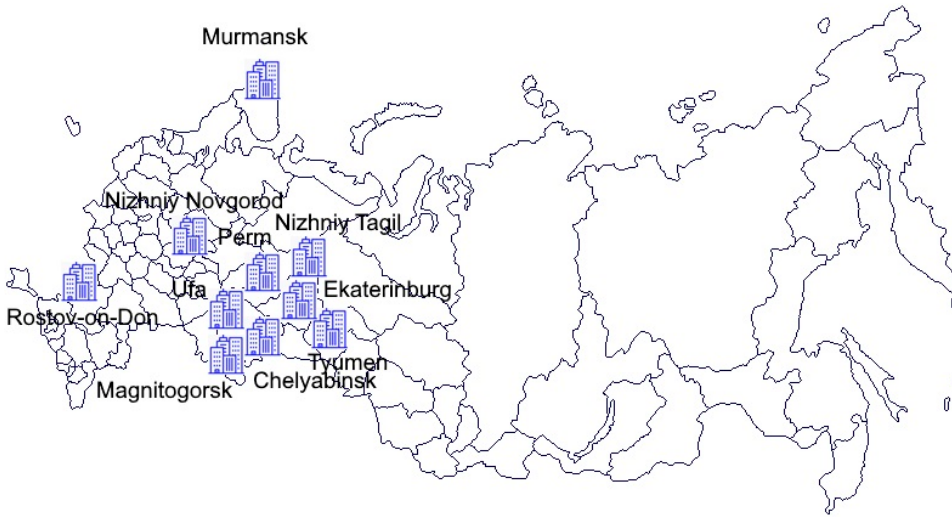
Figure 1. The location of the cities on the map of Russia where the collection of samples of urban surface deposited sediments was performed.